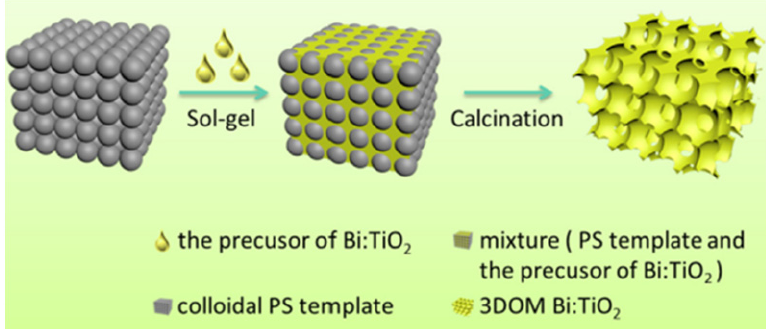
Figure 4. The fabrication process of the 3DOM Bi-doped TiO 2 [26].